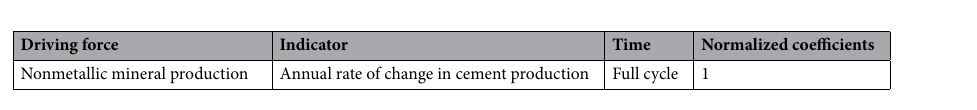
Table 6. CO 2 emissions driving forces in industrial